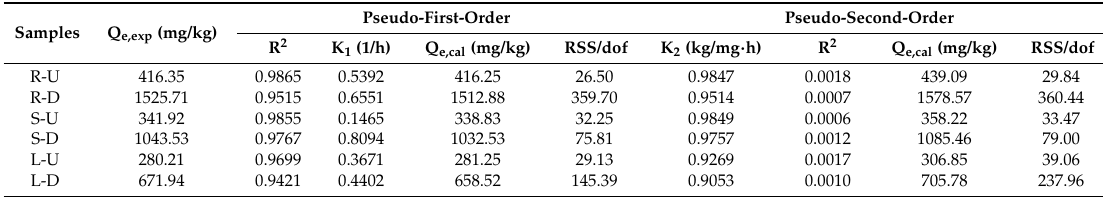
Table 1. Pseudo-first-order and pseudo-second-order model-fitted parameters for OTC adsorption by